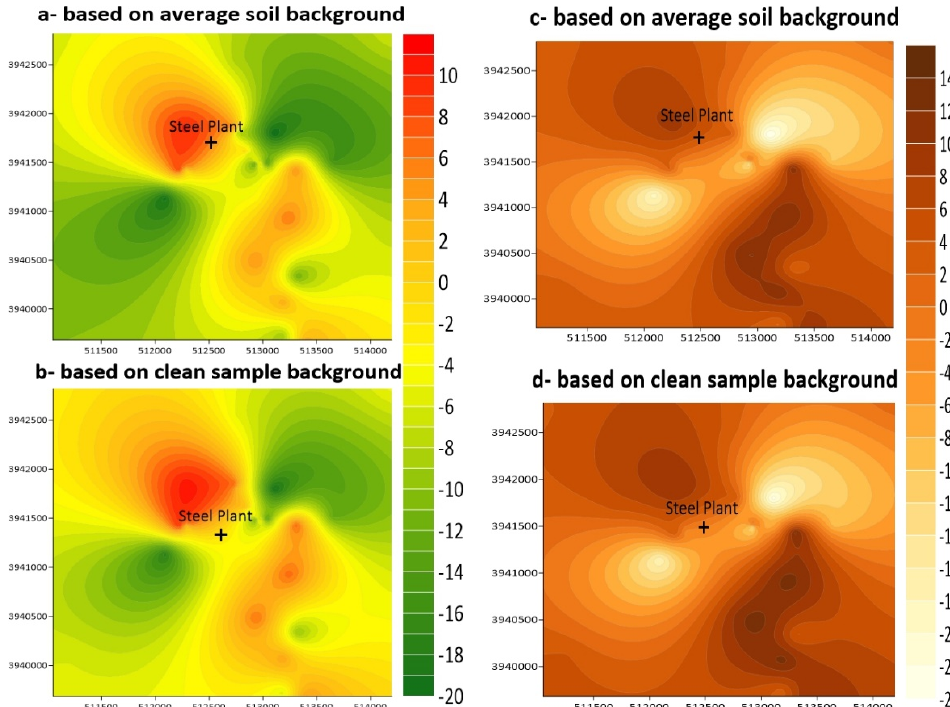
Figure 8. I geo for trace elements and REEs calculated based on average world soil data (( a , c ) respec- tively) or average values in reference soils (( b , d ) respectively).